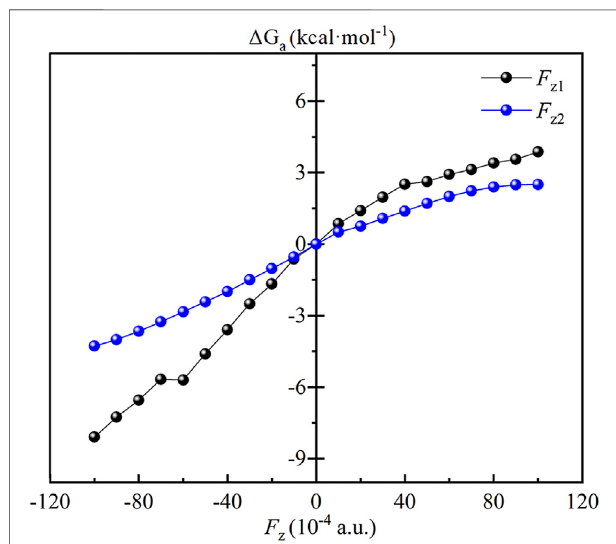
FIGURE 7 | Plots of the relative energy barrier ( Δ G a , kcal · mol − 1 ) of the CH 4 oxidation catalyzed Fe(IV)-Oxo-Cz.